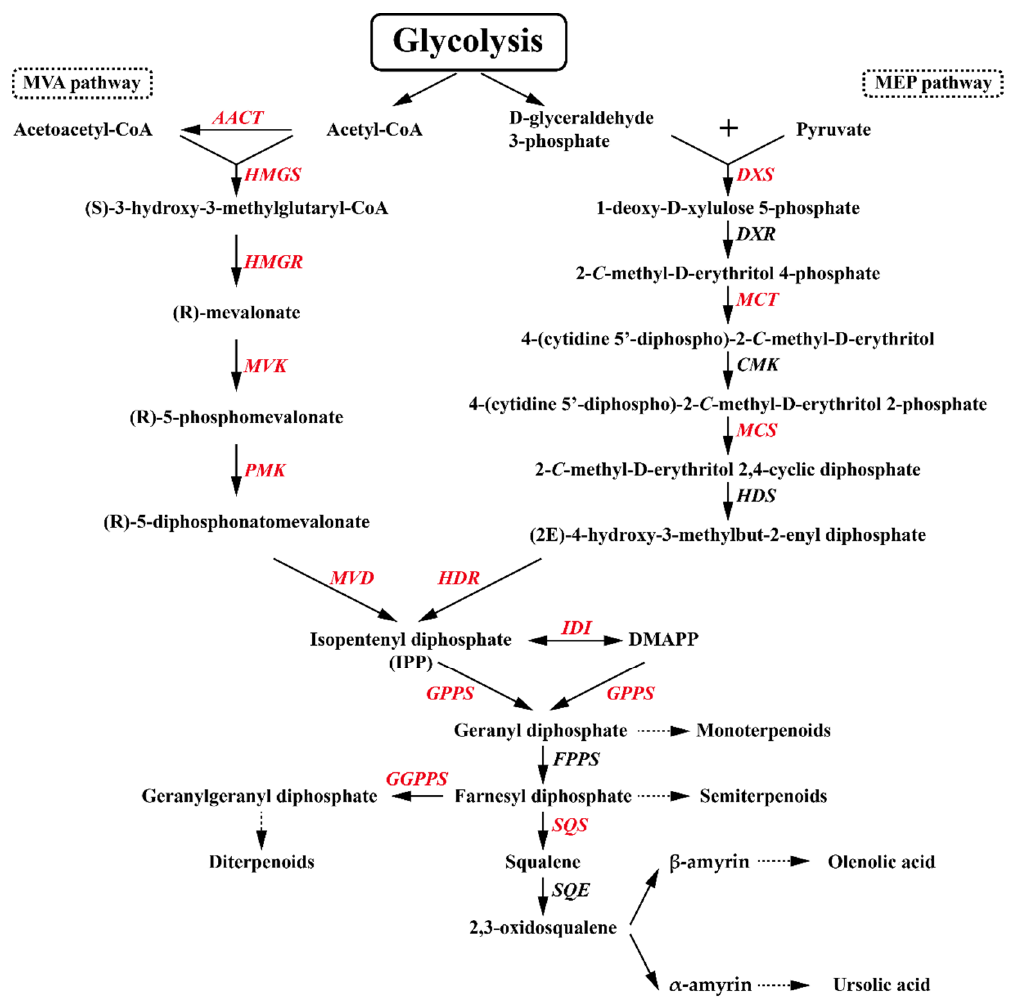
Figure 2. The proposed pathway for the biosynthesis of oleanolic acid and ursolic acid. The terpenoid biosynthetic genes identified in this study are indicated in red: MVA, mevalonic acid; MEP, 2- C -methyl-D-erythritol 4-phosphate; IPP, isopentenyl diphosphate; DMAPP, isomer dimethylallyl diphosphate; AACT, acetyl-CoA acetyltransferase; HMGS, hydroxymethylglutaryl-CoA synthase; HMGR, 3-hydroxy-3-methylglutaryl-CoA reductase; MVK, mevalonate kinase; PMK, phosphomevalonate kinase; MVD, mevalonate-5-pyrophosphate decarboxylase; DXS, 1-deoxy-D-xylulose-5-phosphate synthase; DXR, 1-deoxy-D-xylulose 5-phosphate reductoisomerase; MCT, 2- C -methyl-D-erythritol 4-phosphate cytidylyltransferase; CMK, 4-diphosphocytidyl-2- C -methyl-D-erythritol kinase; MCS, 2- C -methyl-D-erythritol 2,4-cyclodiphosphate synthase; HDS, 4-hydroxy-3-methylbut-2-enyl-diphosphate synthase; HDR, 4-hydroxy-3-methylbut-2-enyl diphosphate reductase; IDI, isopentenyl diphosphate isomerase; GPPS, geranyl diphosphate synthase; GGPPS, geranylgeranyl diphosphate synthase; FPPS, farnesyl pyrophosphate synthase; SQS, squalene synthase; and SQE, squalene epoxidase.